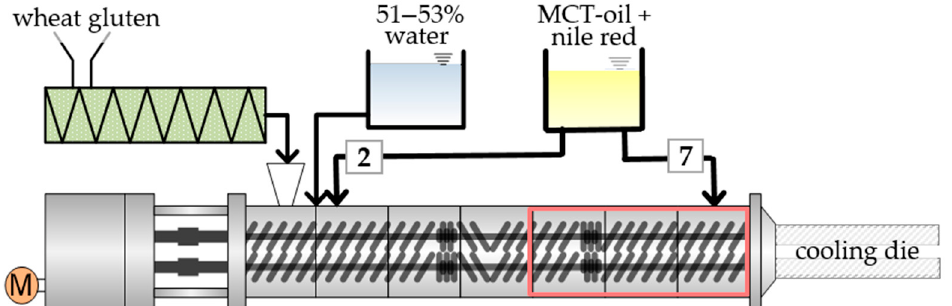
Figure 1. Schematic illustration of experimental setup for extrusion trials. Variable process parameters were the oil content (0, 2, 4, 6%), oil addition point (position 2 and 7), screw speed (200, 400, 800 rpm) and barrel temperature in segments 5–7 (120 or 140 ◦